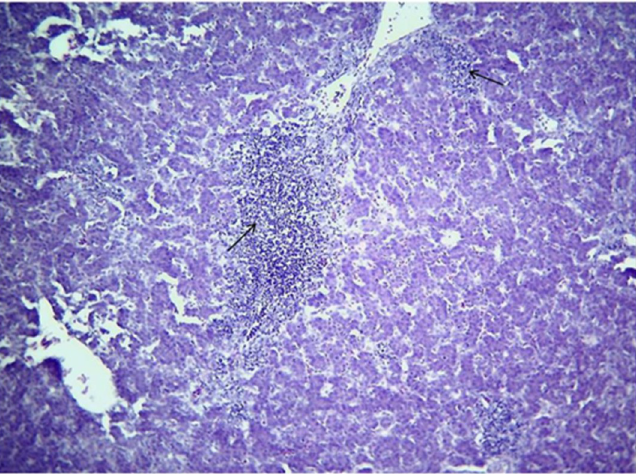
Fig 6. Liver at 9 dpi chick inoculated with FAdV-11 field strain (MOR300315) -Heavy inflammatory cell infiltrate in the portal spaces (Arrows). H&E, X100.